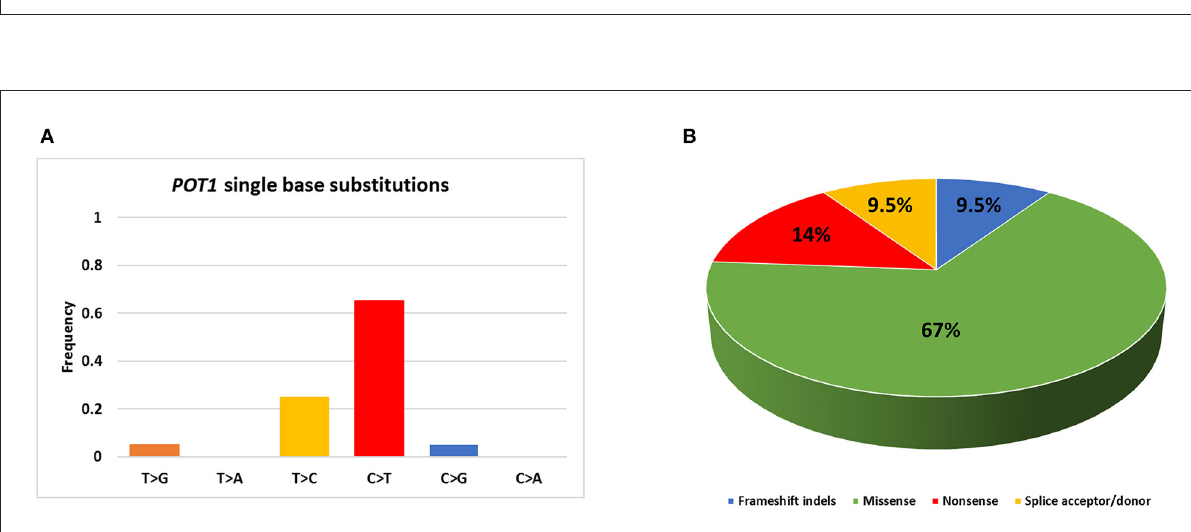
FIGURE2 Summary of POT1 mutations identified in the present study. (A) Percentage of single base substitutions; (B) Percentage of mutations belonging to each